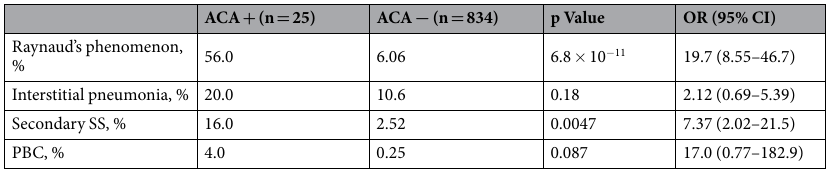
Table 3. Clinical manifestations and complications in ACA-positive RA patients. ACA, anti-centromere antibody; OR, odds ratio; 95% CI, 95% confidence interval; SS, Sjögren’s syndrome; PBC, Primary biliary cirrhosis.